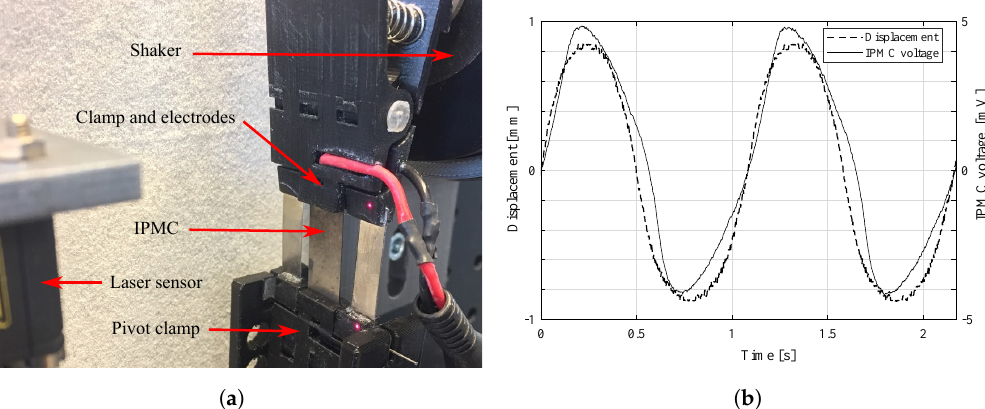
Figure 2. Implementation of IPMC sensing. ( a ) IPMC is mechanically excited using a shaker, while measuring the displacement and generated voltage. ( b ) Measured voltage readings in response to 1 Hz